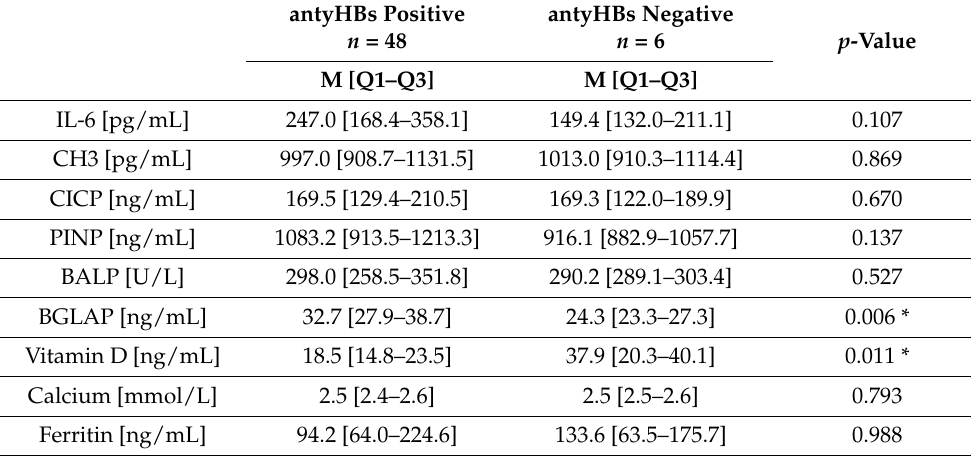
Table 6. Comparison of concentrations of interleukin 6 (IL-6); citrullinated histone CH3 (marker of neutrophil extracellular trap); markers of bone formation (osteocalcin (OT), bone alkaline phosphatase (BALP), N-terminal propeptide of type I procollagen (P1NP)); bone resorption marker-C-terminal telopeptide of type I collagen (C1CP); and vitamin D, ferritin and serum calcium, depending on the presence of serum anti-HBS antibodies (reactive or non-reactive result) (median and Q1–Q3). antyHBs Positive antyHBs Negative n = 48 n = 6 p -Value M [Q1–Q3] 247.0